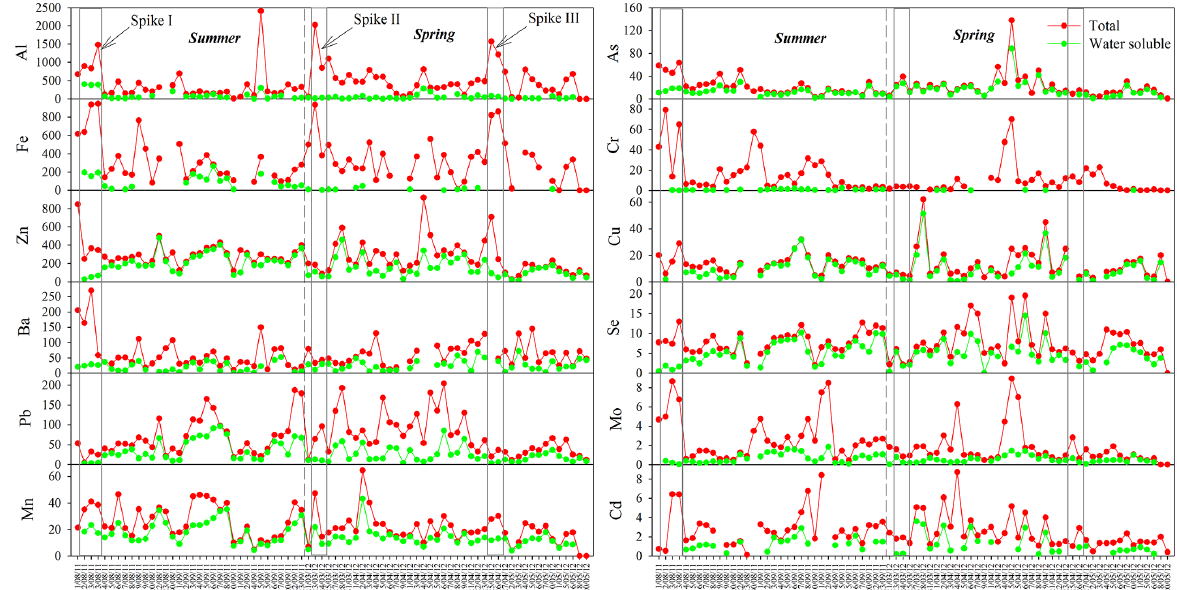
Figure 2. Temporal variations of individual trace element concentrations (ngm − 3 ) in PM 2 . 5 at Mt. Lushan. Boxes indicate the concentration spikes.